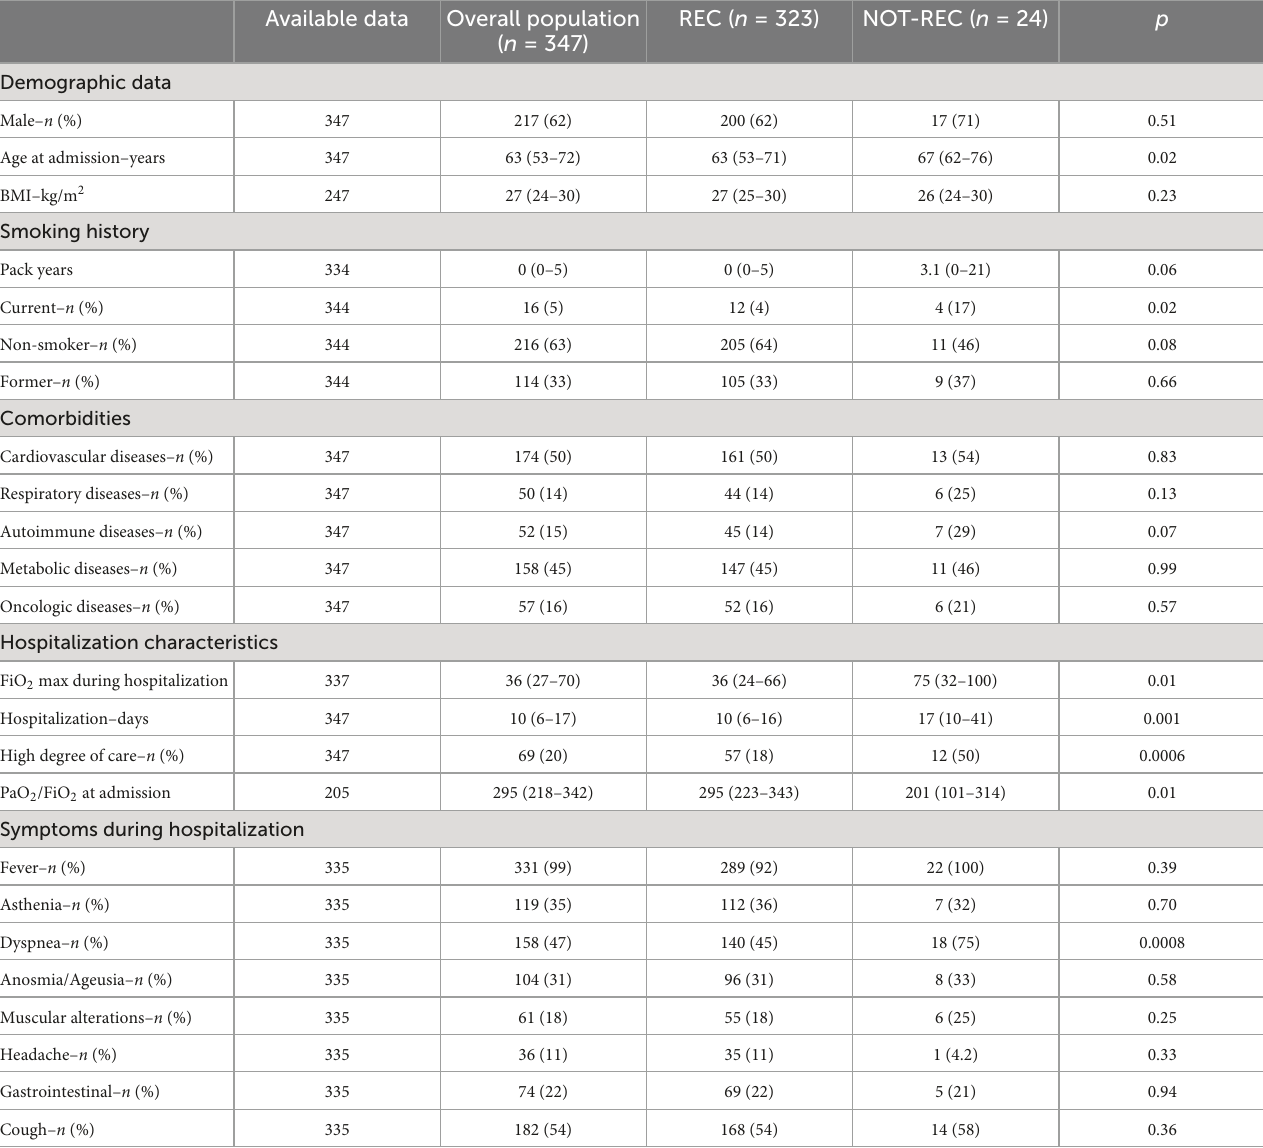
TABLE 1 Baseline demographics and clinical characteristics of the overall population evaluated at post-COVID clinic, and of the two subgroups categorized according to the presence or absence of radiological recovery at 12 months. Available data Overall population REC ( n = ( n = 347)